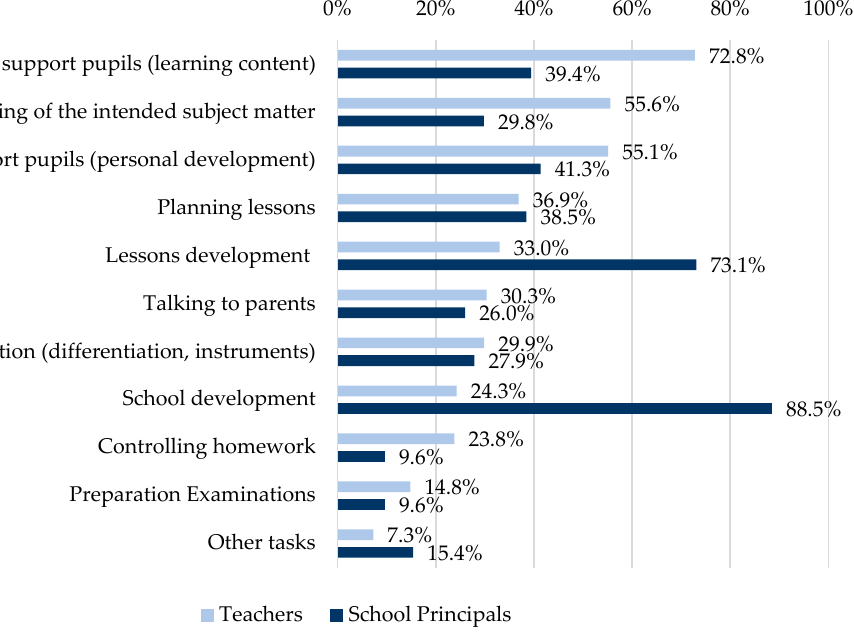
Figure 1. Which professional tasks do you not manage during the pandemic, or at least not to the extent that you would like to? (Multiple answers possible).